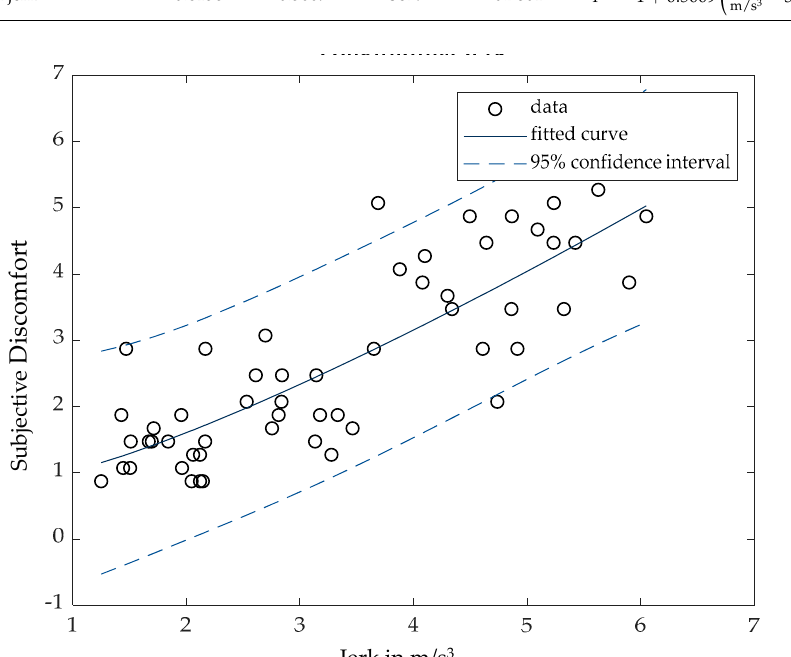
Table 3. Results from the regression analysis for all objective values in Maneuver A.